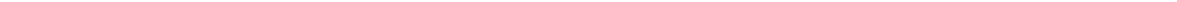
Fig. 1 Testosterone regulates splenic B cell number. a Representative plots of CD19 + CD93 + transitional B cells (tB) and CD19 + CD93 – mature B cells (matB) in the spleen from male control ( Pgk-Cre + ) and general androgen receptor knockout (G-ARKO) mice. b Total CD19 + B cells in the spleen in control ( n = 10) and G-ARKO ( n = 9) mice. c Total CD19 + B cells in the spleen in castrated (ORX) control and G-ARKO male mice treated with placebo (P)